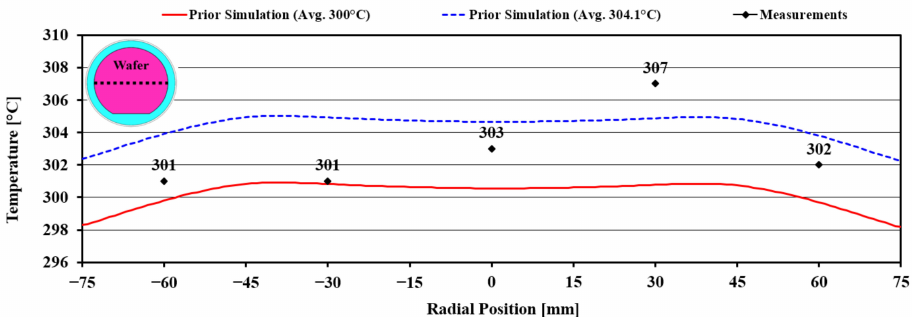
Figure 9. Comparison of horizontal temperature variation between a previous simulation study in solid lines and the present measurements in dotted